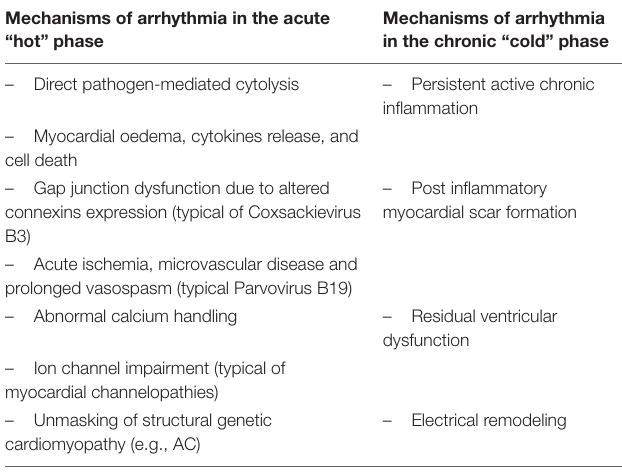
TABLE 2 | Different molecular and immunopathogenic mechanisms involved in the disease process according to the disease phase: acute “hot” versus chronic